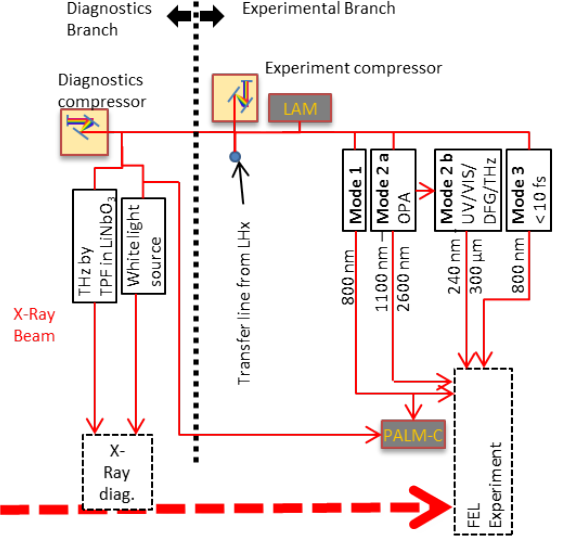
Figure 11. Available operation modes for X-ray diagnostics and FEL experiments. From